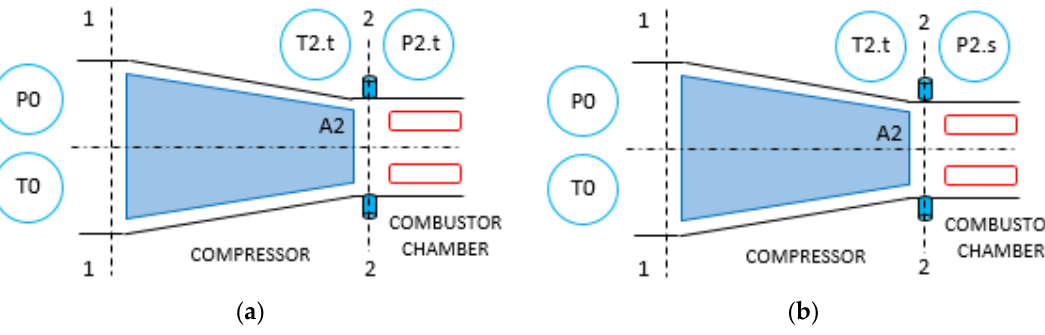
Figure 2. Compressor instrumentation method scheme, model ( a ); compressor instrumentation method scheme, model ( b ).